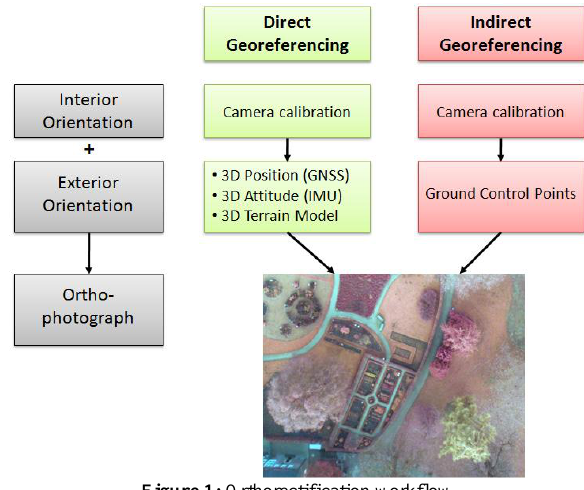
Figure 1: Orthorectification workflow.